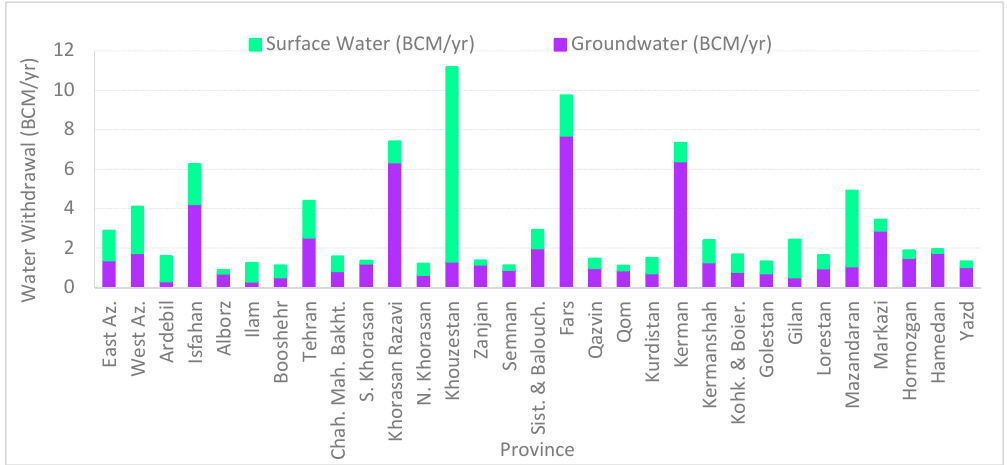
Figure 5. Total surface water and groundwater withdrawal in different provinces in 2011.